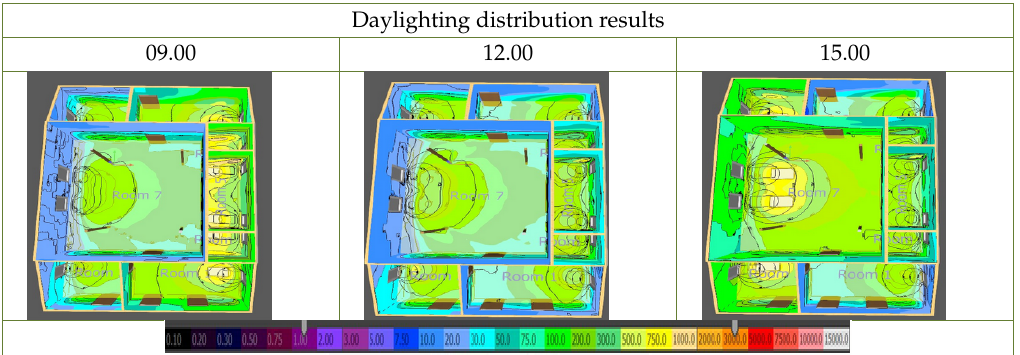
Table 3. Simulation results describes daylighting